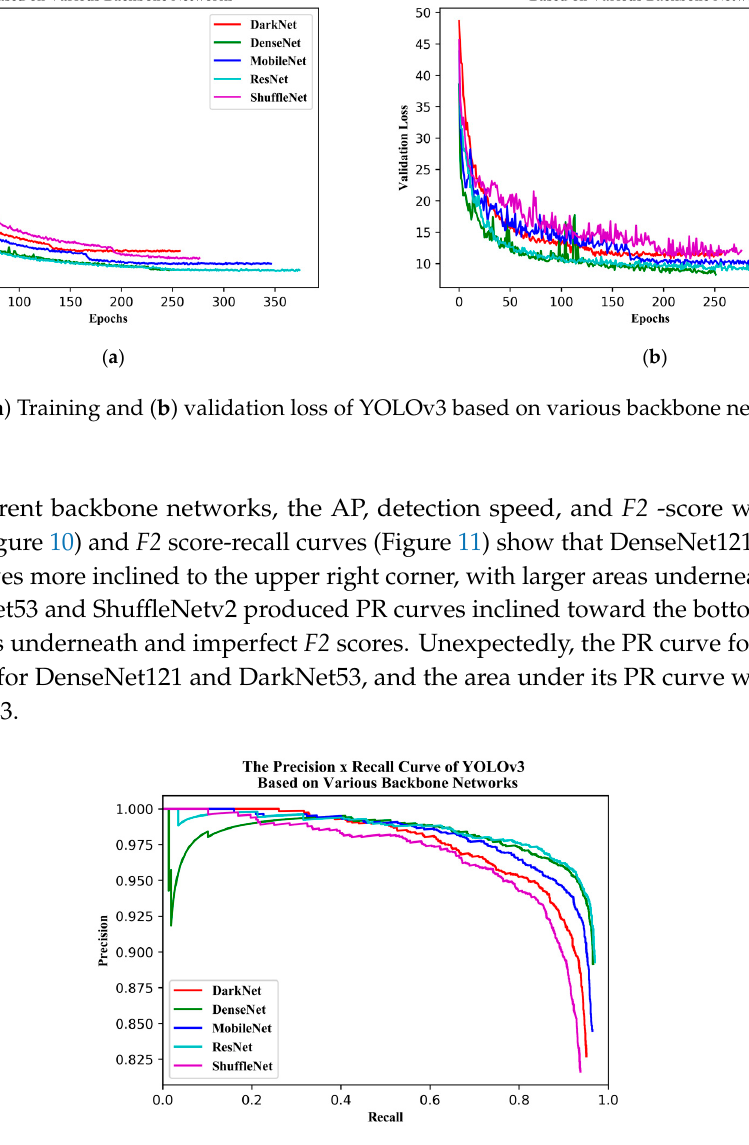
Table 5. Convergency epochs of YOLOv3 based on various backbone networks.